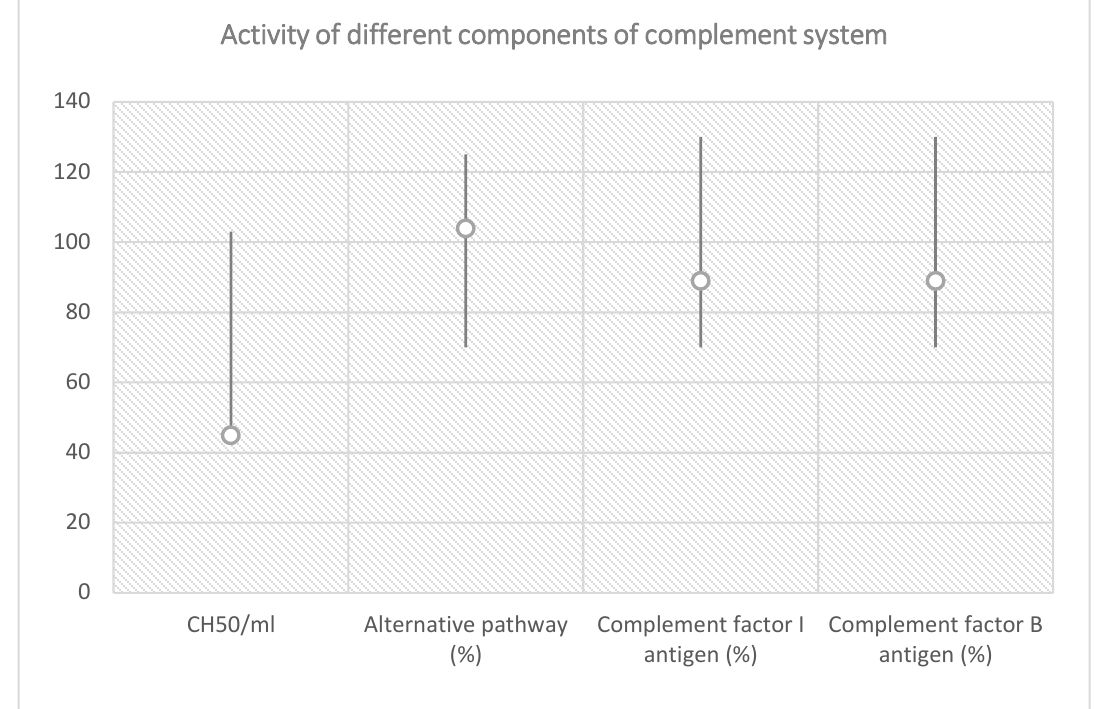
Figure 2. Classical pathway, alternative pathway, complement factor I and factor B antigen activity in relation with reference range.